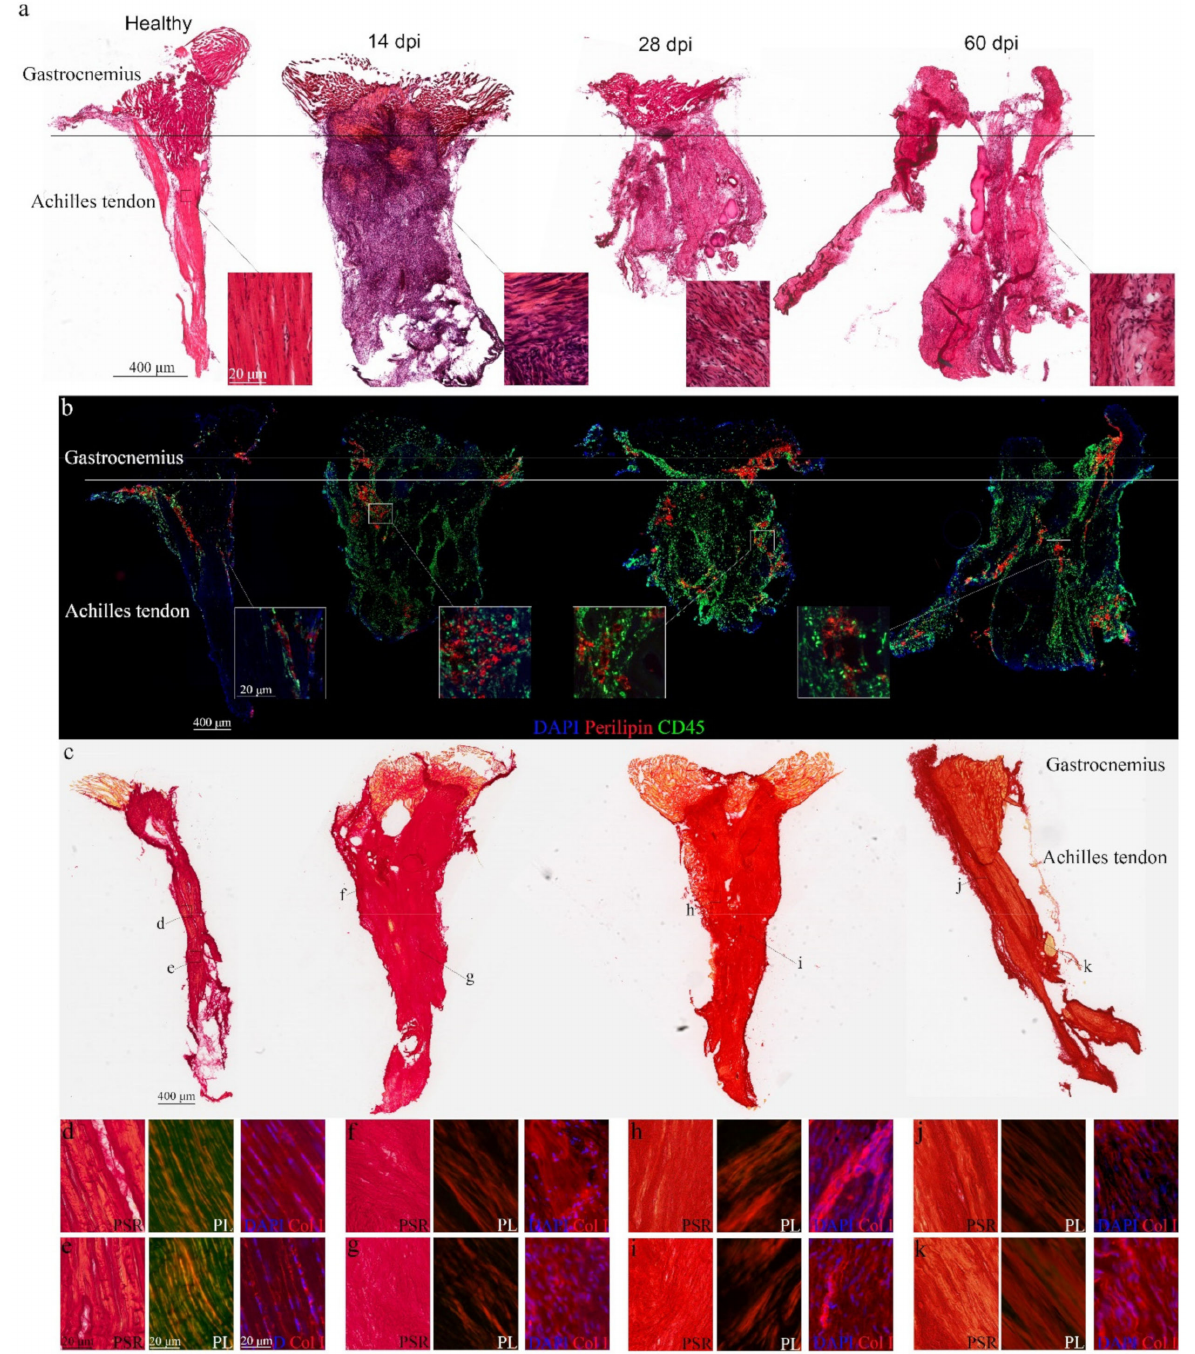
Figure 1. Characterization of damage in Achilles tendon after complete rupture. ( a ) Representative tissue sections of healthy and injured Achilles tendons stained for H&E; image scale bar 400 µ m; insert scale bar 20 µ m; ( b ) with inserts highlighting tissue microstructure in healthy and injured Achilles tendons and representative images of tendons immunostained for CD45/perilipin; image scale bar 400 µ m; insert scale bar 20 µ m; ( c ) Picrosirius red staining of tissue cryosections; image scale bar 400 µ m; and ( d – k ) inserts pointing to areas visualizing collagen fiber arrangement under normal or polarized light and after collagen I immunostaining; image scale bar 20 µ m. DAPI was used to identify all nuclei. dpi, days post-injury; PSR, Picrosirius red; Col I, collagen type